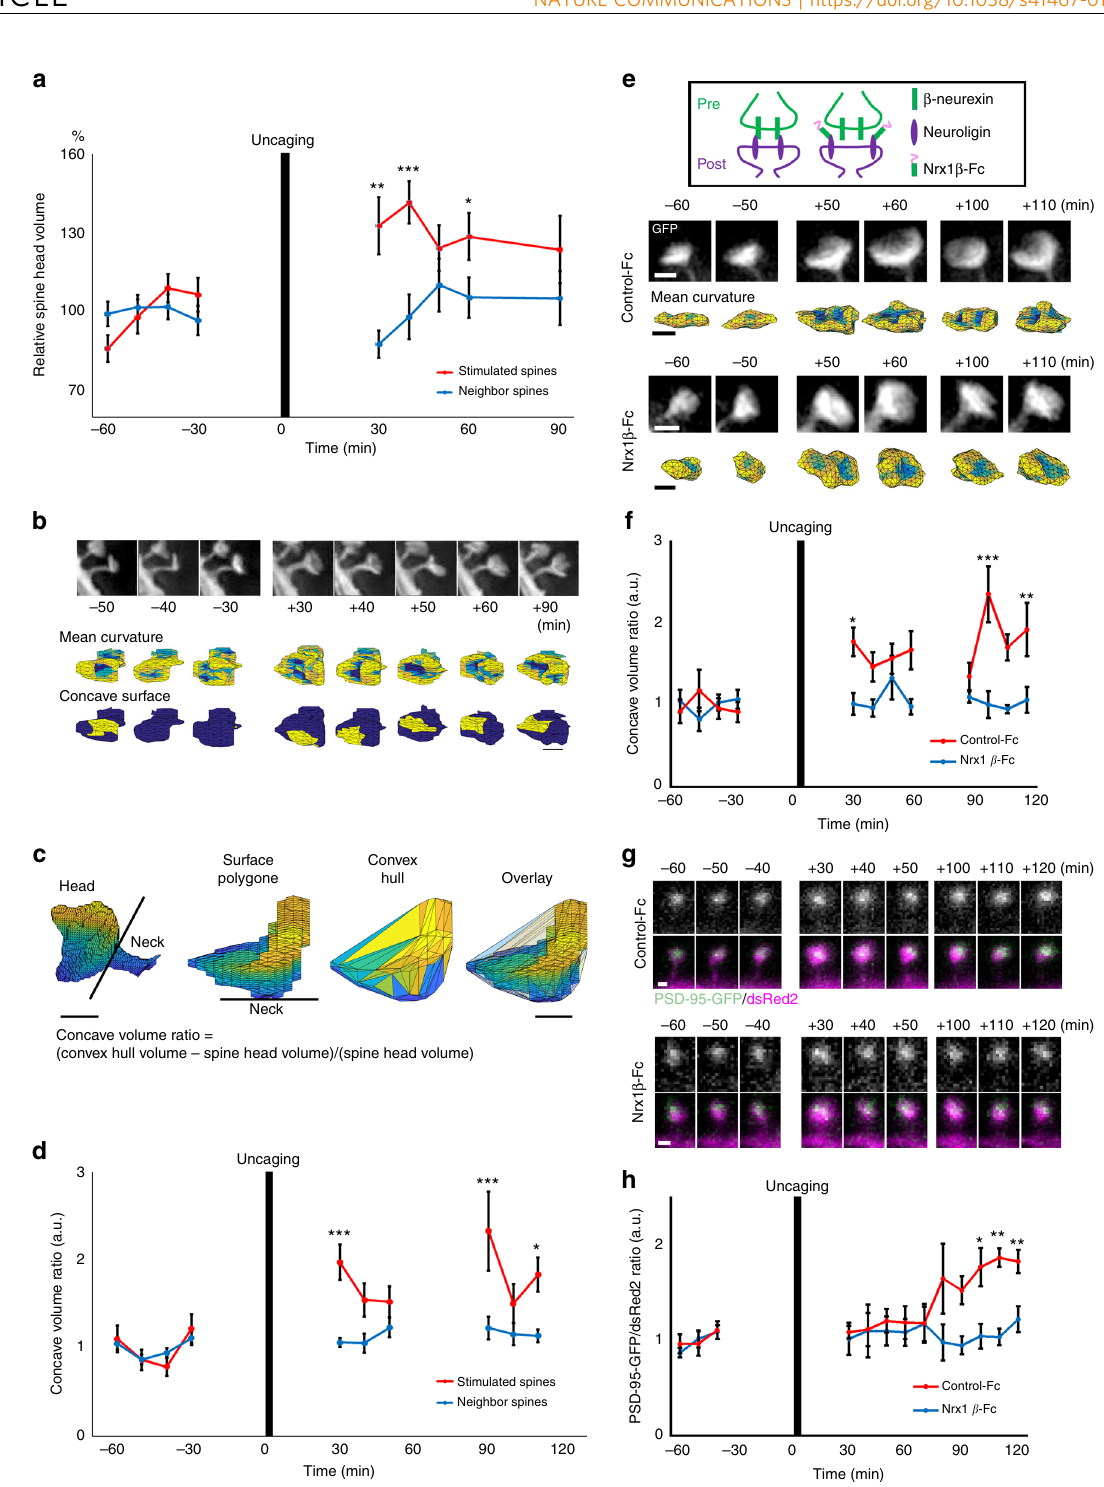
than that of other neuroligin isoforms 29 , we expected that exogenous application of neurexin 1 β -IgG fusion protein (neurexin 1 β -Fc) would effectively and transiently block neuro- ligin 1 function (Fig. 4e). This manipulation inhibited enlarge- ment and stabilization of the concave surface, supporting the idea that membrane adhesion mediated by neuroligin 1 is involved in increasing the junctional surface of spines (Fig. 4f). This neuroligin-dependent mechanism of stabilization of the post- synaptic concave surface may be independent from the